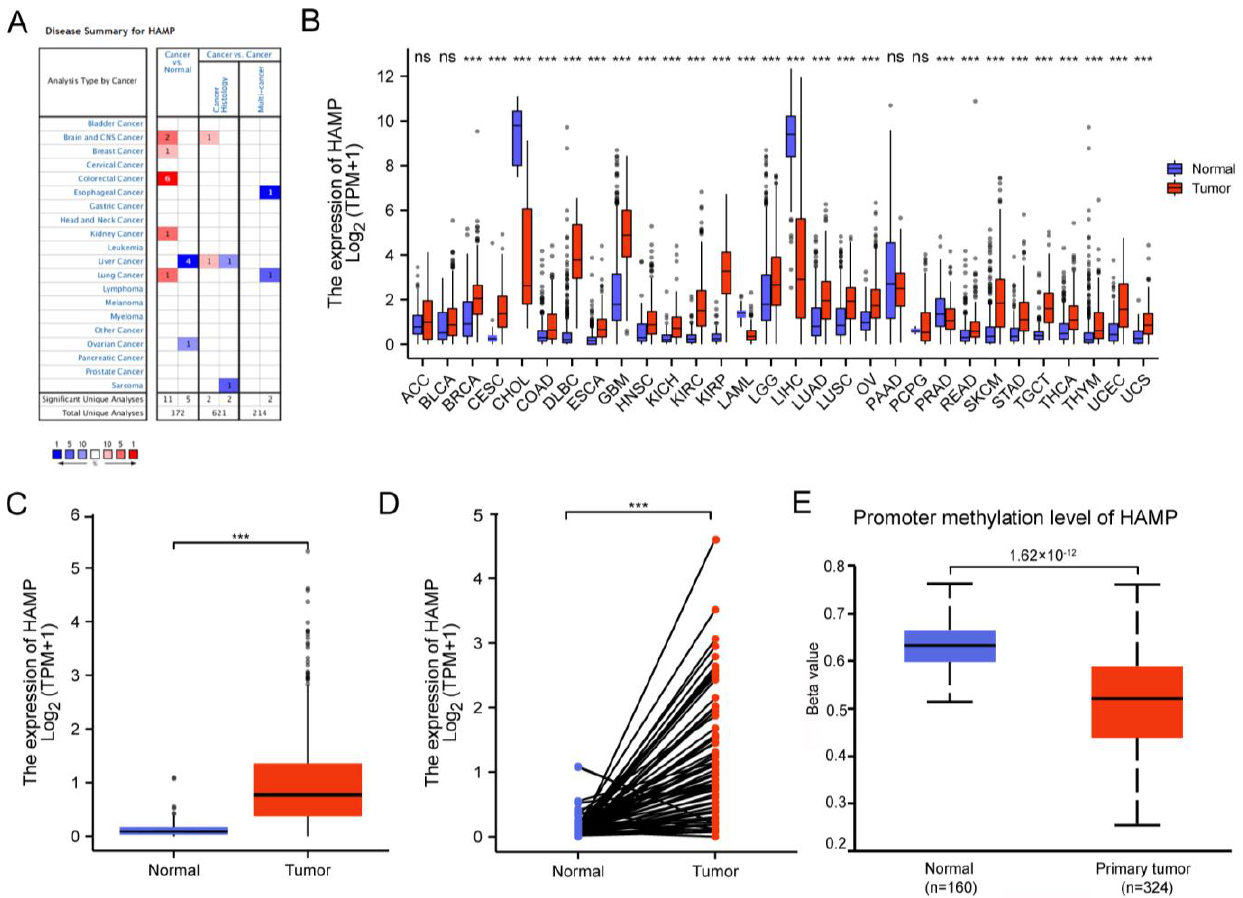
Figure 1. Differential HAMP expression levels in tumors and normal tissues. ( A ) Expression levels of HAMP in different cancers compared with normal tissues in the Oncomine database. ( B ) Comparison of the expression levels of HAMP in different cancers from the TCGA database. ( C , D ) The unpaired and paired expression levels of HAMP, compared between tumor ccRCC tissues ( n = 539) and normal tissues ( n = 79) in the TCGA database. ( E ) The hypermethylation level of HAMP in ccRCC tissues analyzed by the Ualcan database (*** p < 0.005).